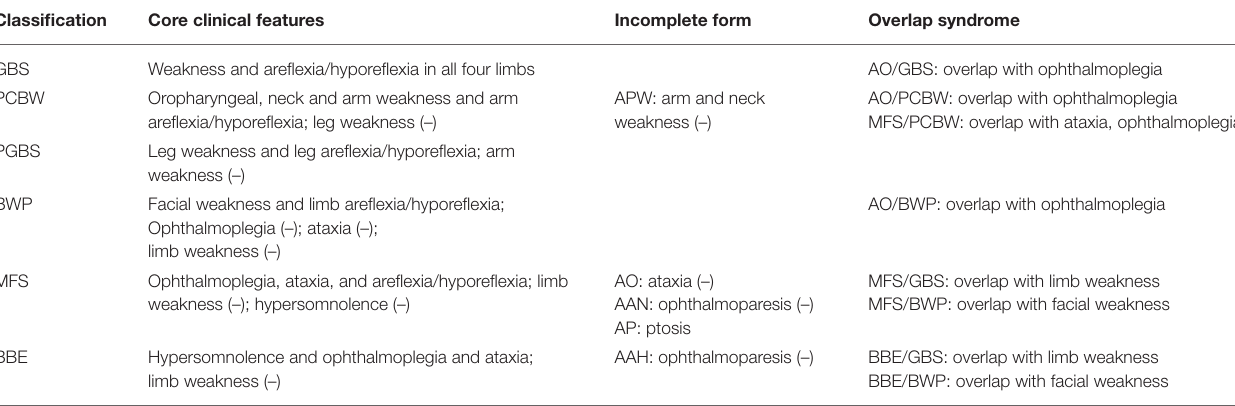
TABLE 1 | Diagnostic criteria of anti-GQ1b antibody syndrome in this study. Classification